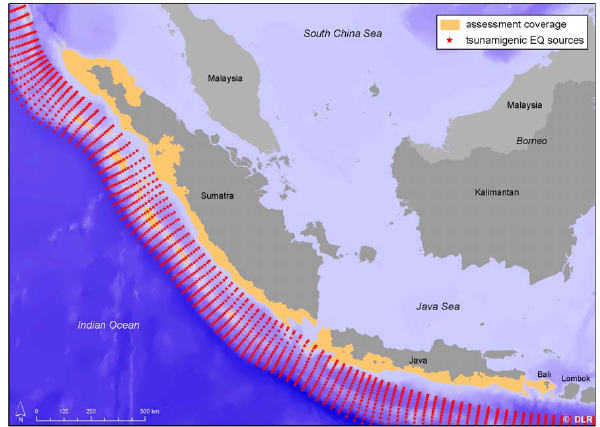
Fig. 3. The location of the tsunamigenic earthquake sources obtained from the scenario database used in the tsunami modelling. Each star represents characteristic elicitation parameters for different moment magnitudes (for details see Babeyko et al.,